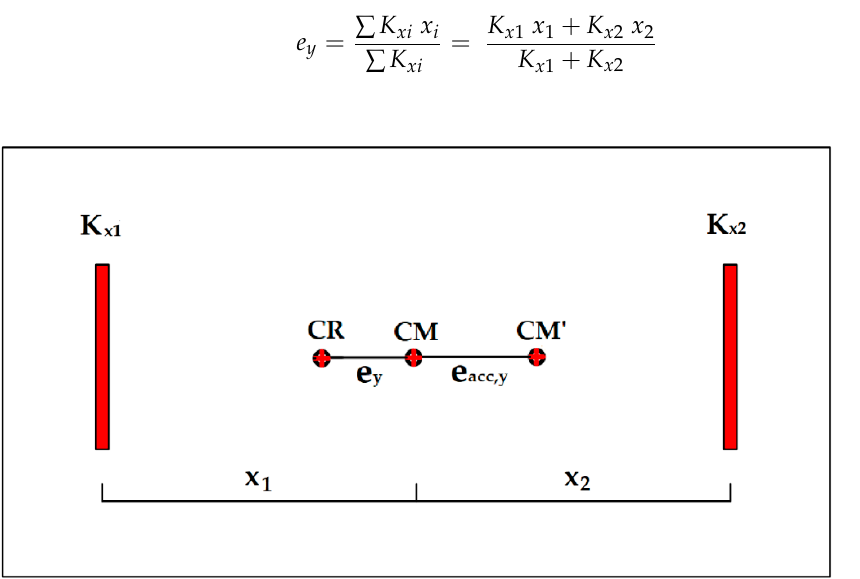
Figure A1. Pure SW building consisting of pairs of shear walls.